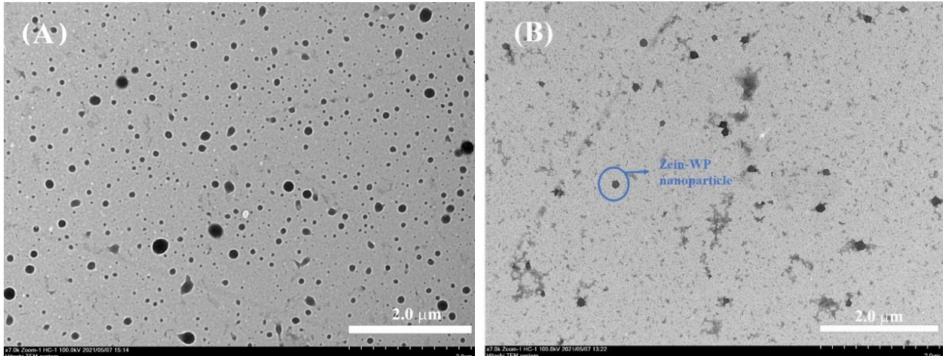
Figure 5. TEM images of CBD-loaded zein nanoparticle ( A ) and CBD-loaded zein–WP nanoparticle ( B